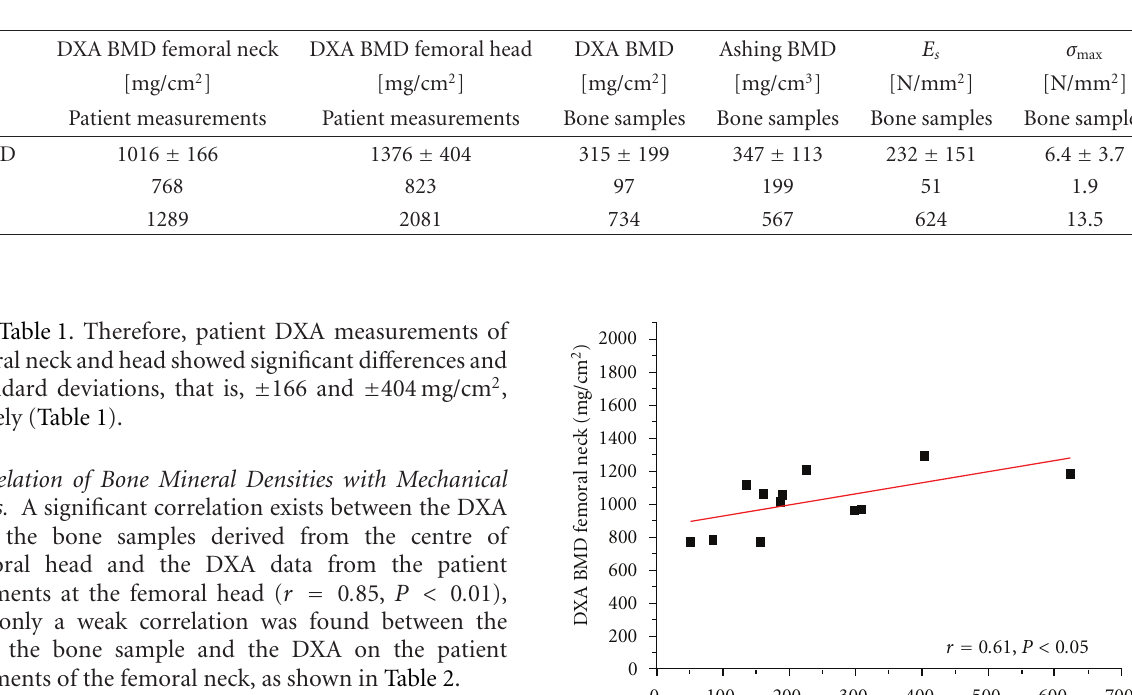
Table 1: Mean value ± standard deviation (SD), minimum and maximum of bone mineral densities and mechanical properties of 13 bone samples.